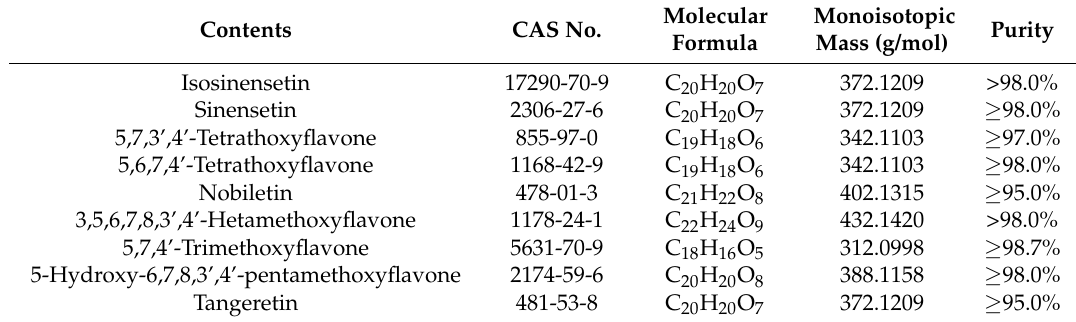
Table 6. The PMFs standards used in this